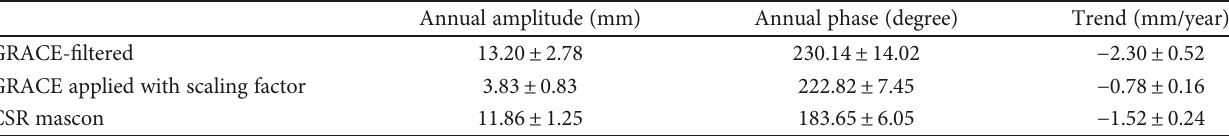
Table 3: Annual amplitude and phase of terrestrial water storage (TWS) from GRACE, mascon, and GLDAS from 2003 to 2014.